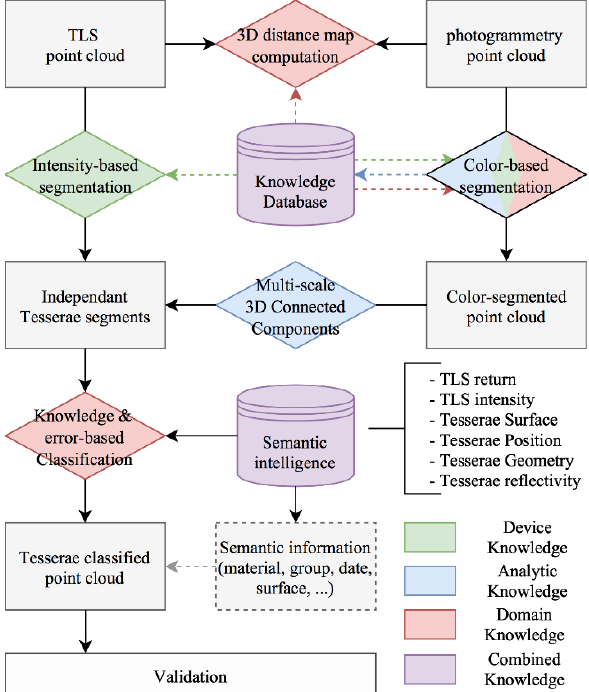
Figure 6 Hybrid segmentation and classification pipeline for an archaeological smart point cloud